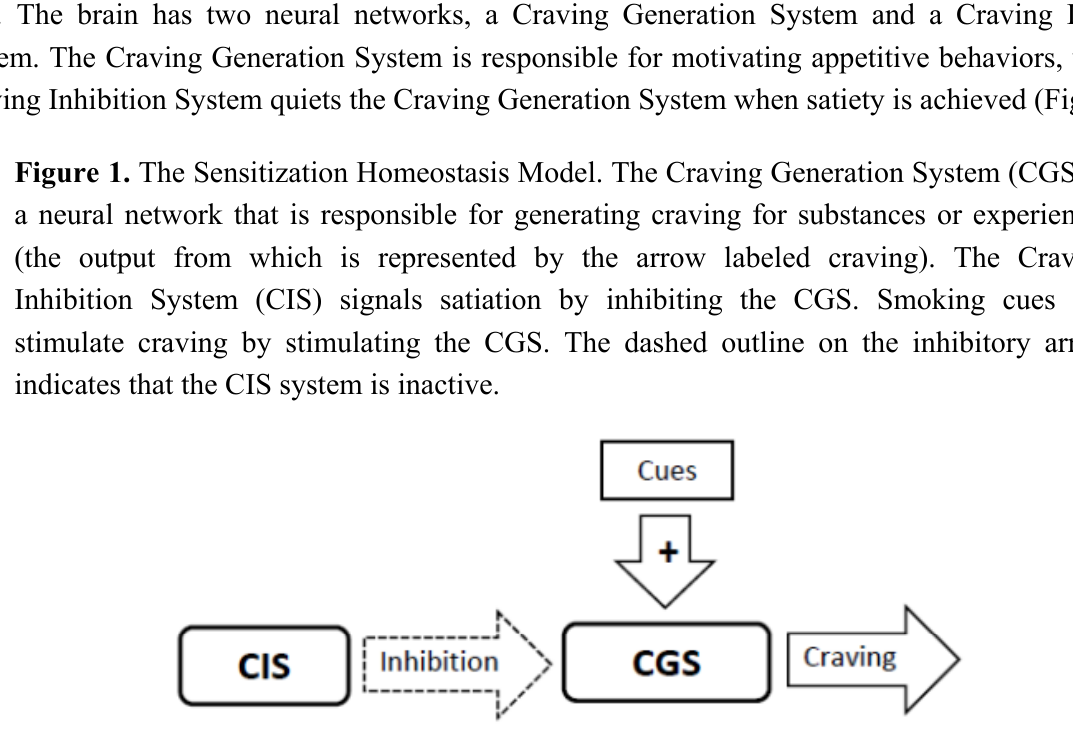
(the output from which is represented by the arrow labeled craving). The Craving